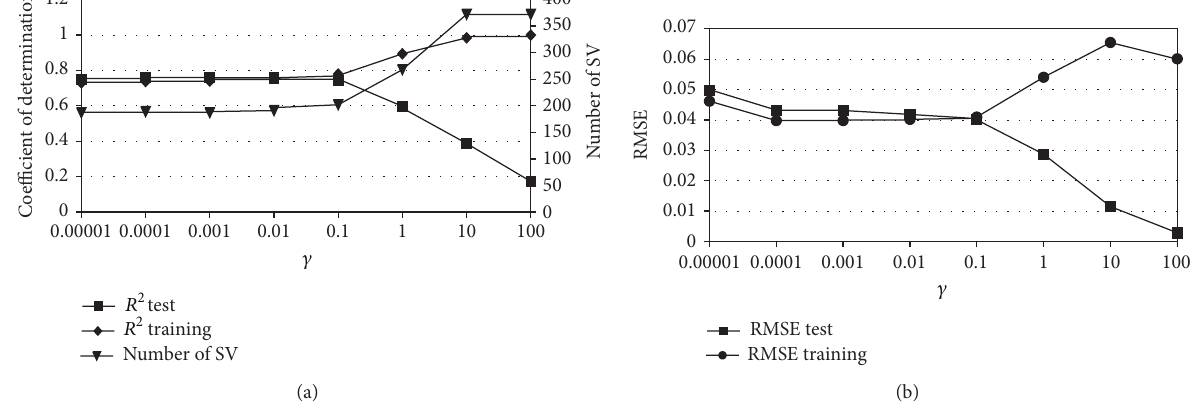
Figure 1: Example of the overfitting phenomenon for the radial basis kernel based ] -SVM model.